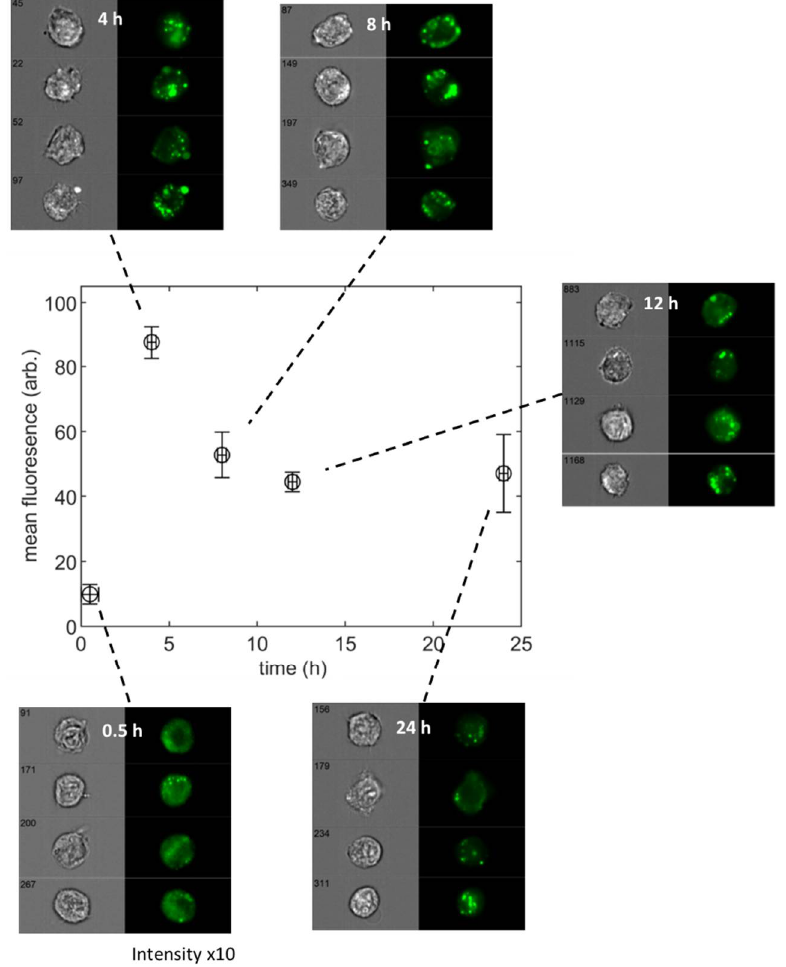
Figure 1. Mean YOYO TM -1 fluorescence (p-DNA marker) per cell from dosing study with ND7/23, neuronal cells exposed to trimethyl chitosan (TMC16) nanoparticles (data from Gomes et al. [28]). The linked panels contain representative bright field and fluorescence images of the cells at each measurement time point (image numbers refer to cell reference in the imaging acquisition stream). The pixel intensity of the fluorescence channel is scaled by a factor of 10 for the 0.5 h time point to enhance visibility. All other images have the same pixel intensity range.